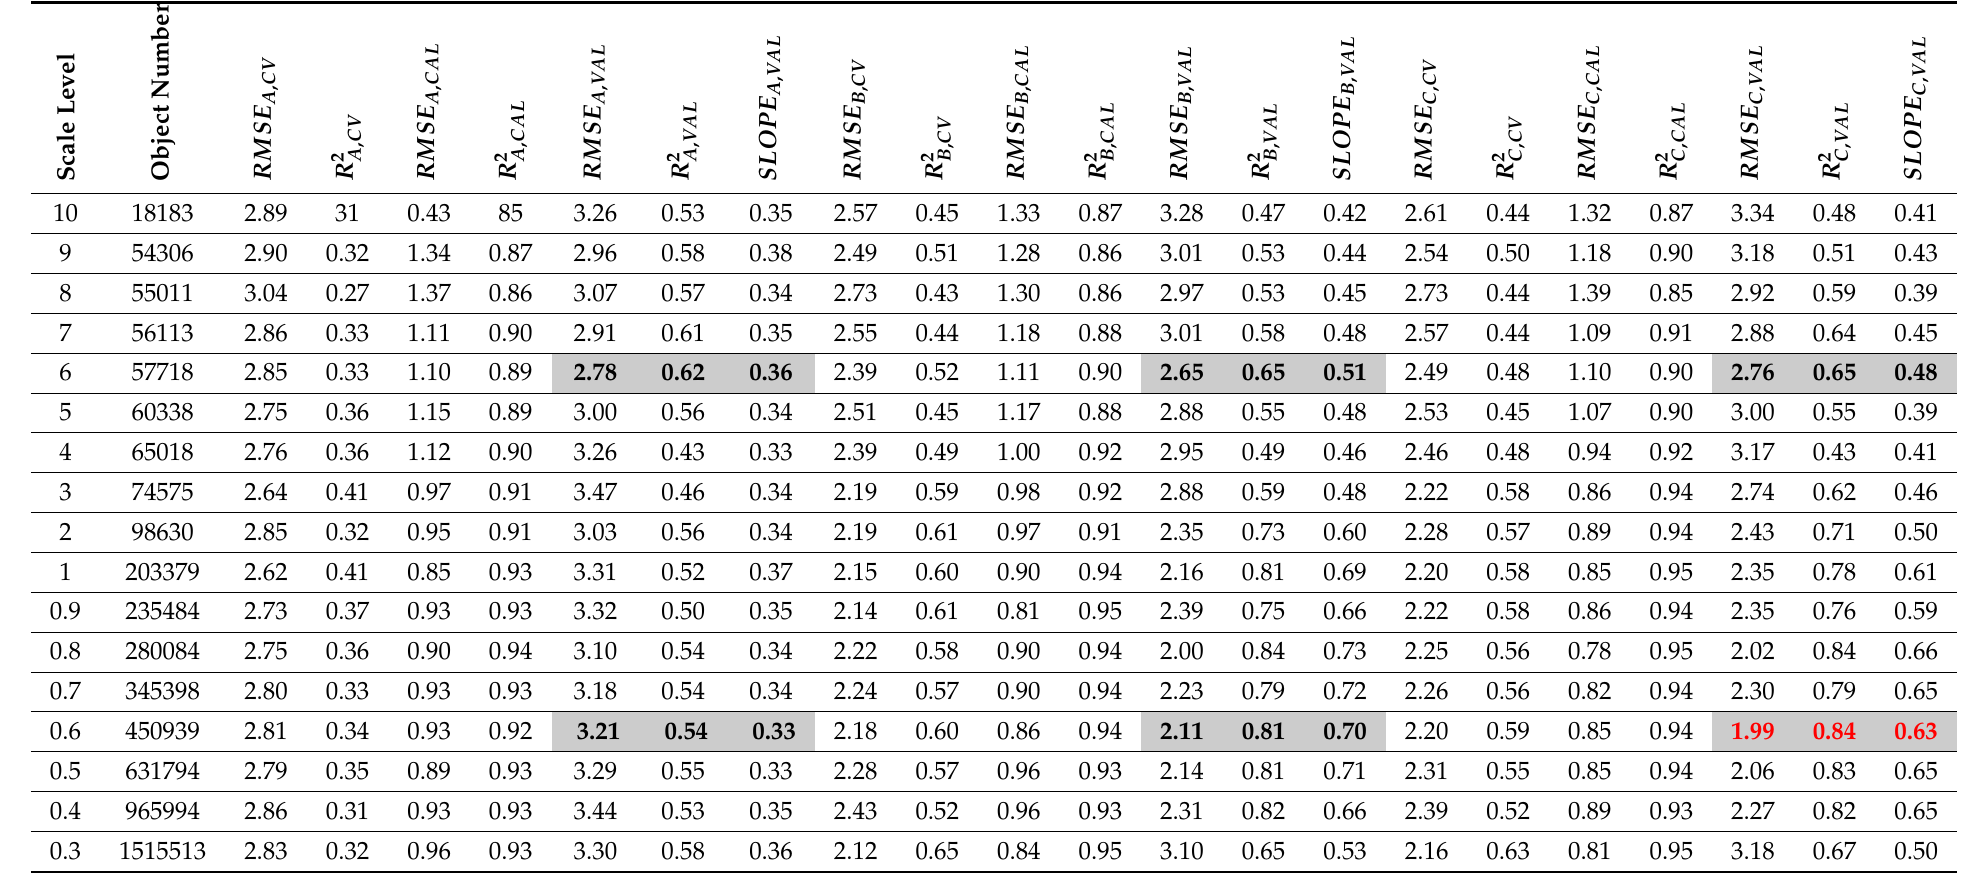
Table 3. Scale-specific accuracy metrics for SOC content (%) prediction variants based on terrain attributes (subscript A; cf. Table 1), SCMaP-SRC (subscript B) and both data sets (subscript C). RMSE —root mean square error; R 2 —coefficient of determination; subscript CV—cross validation; subscript CAL—calibration; subscript VAL—independent validation. The gray and bold emphasized values refer to the prediction variant with highest accuracy metrics (Figure 9 and the corresponding scatter plots (Figure 8). The gray, bold and red values emphasized is related to the best prediction variant (cf., Figure